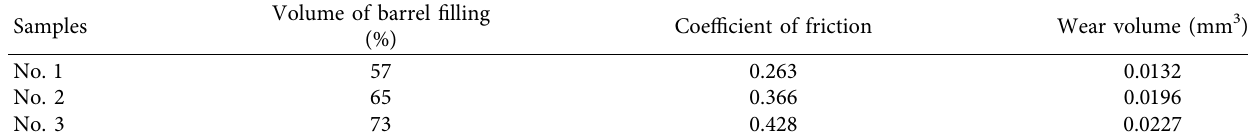
3 C 2 -NiCr coatings.